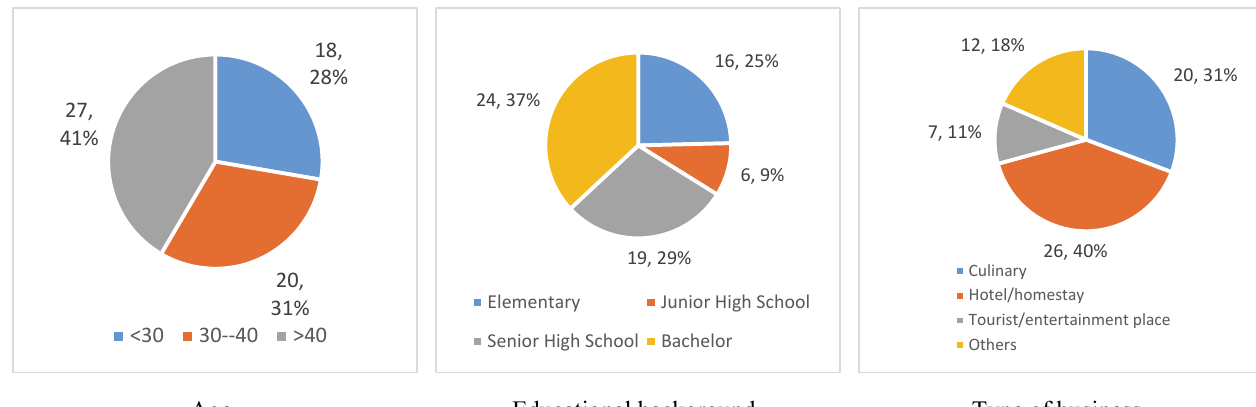
Fig. 1. Personal characteristics of the participants